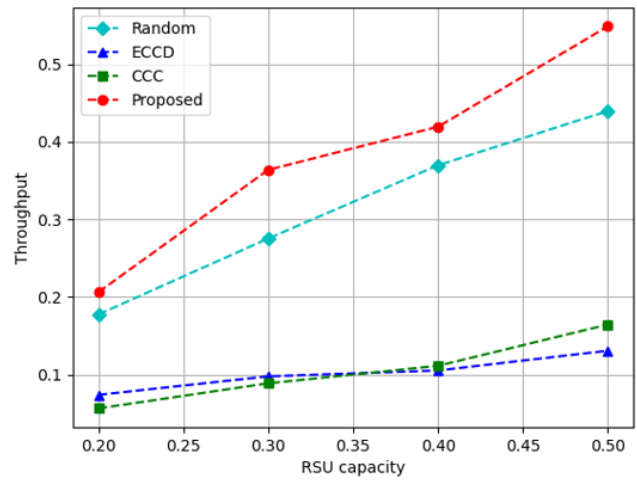
Figure 10. Edge throughput with respect to the increase in the capacity of RSUs.